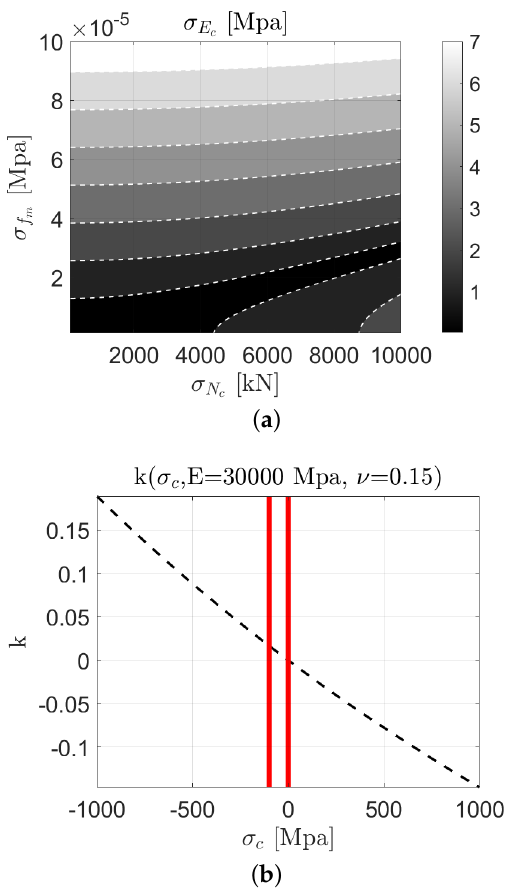
Figure 3. Percentage variation of the natural frequency expressed by the approximate k ratio in Equation (7). ( a ) The variation of both E and σ c ; ( b ) the dependence of the k factor on the natural sole compression stress given the elastic modulus. The solid vertical lines in ( b ) indicate the range of interest in existing concrete structures, averaging between − 100 and 0